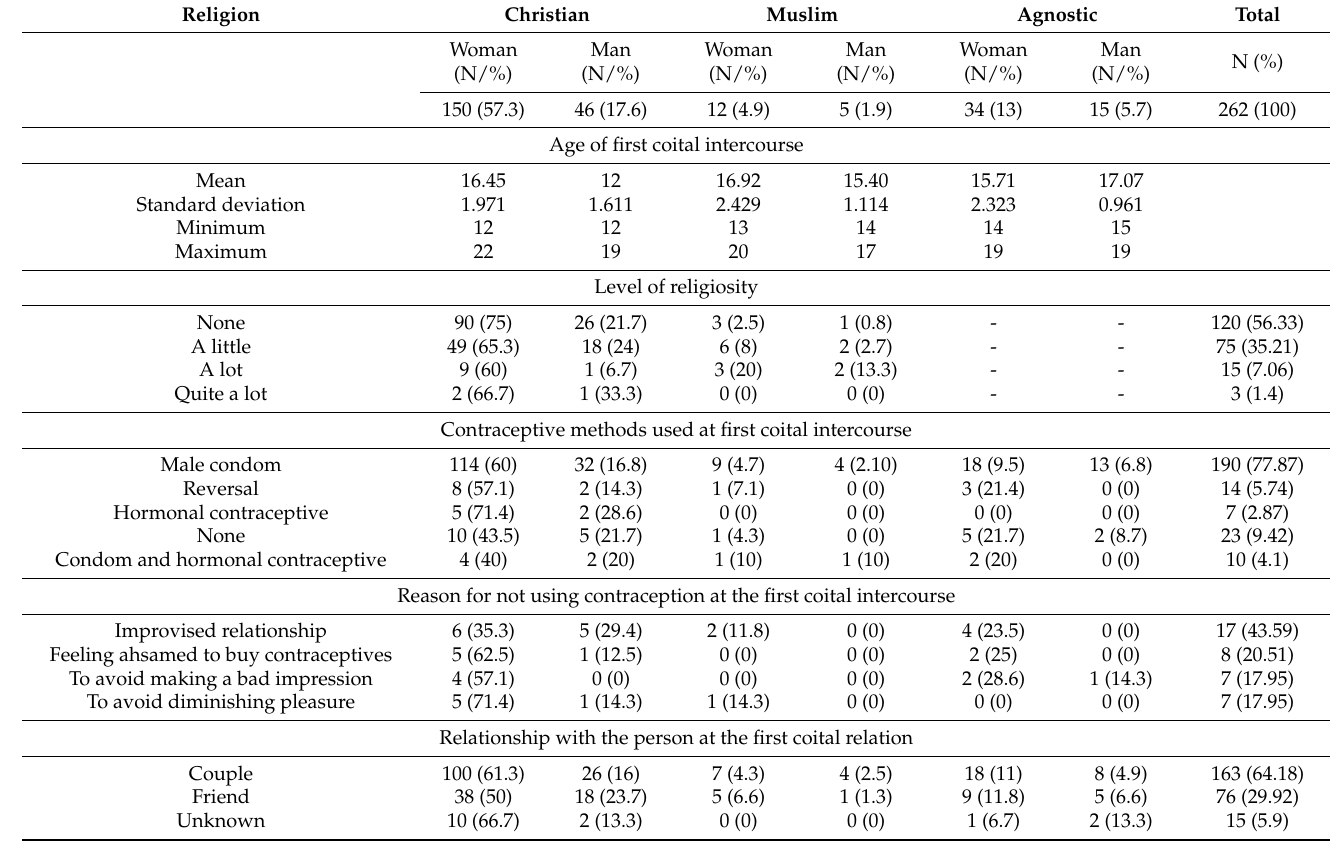
Table 4. Participants who had had penetrative sex according to sex variables and their religion.